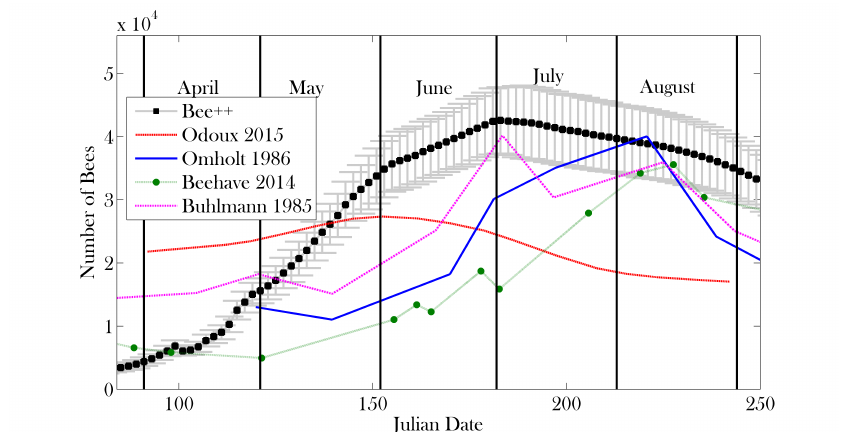
Figure 7. Total bee population from early spring to late summer using data from 10 simulations with the same parameter set (mean in black circles, grey error bars show ± one standard deviation). These 10 simulations begin after the model has simulated 12 years of data, thereby representing the colony size and distribution of a well established colony. Results from the model are compared with those of other studies [52,70–72]. The simulation agrees qualitatively with previous models (Omholt) [71], observation (Buhlmann) [72], and simulation (Beehave) [52]. Data from Odoux [70] were obtained by model fitting, using measurements from many colonies. In the Bee++ example we have assumed constant availability of food in the environment and therefore we see a larger peak